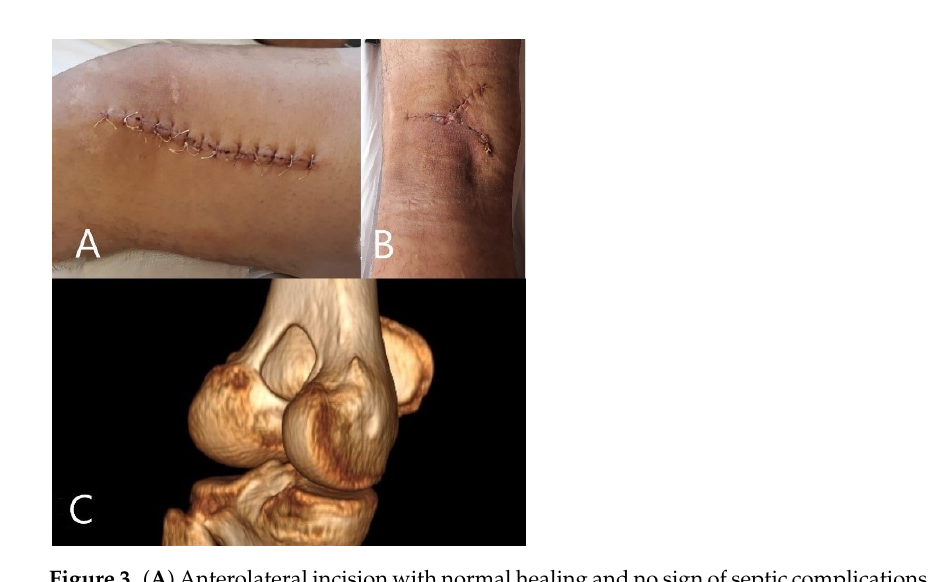
Figure 3. ( A ) Anterolateral incision with normal healing and no sign of septic complications. ( B ) Posterior scar used for soft tissue debridement. ( C ) CT reconstruction after surgery showing post-operative aspect with bone inducing cement filling the remaining bone defect.